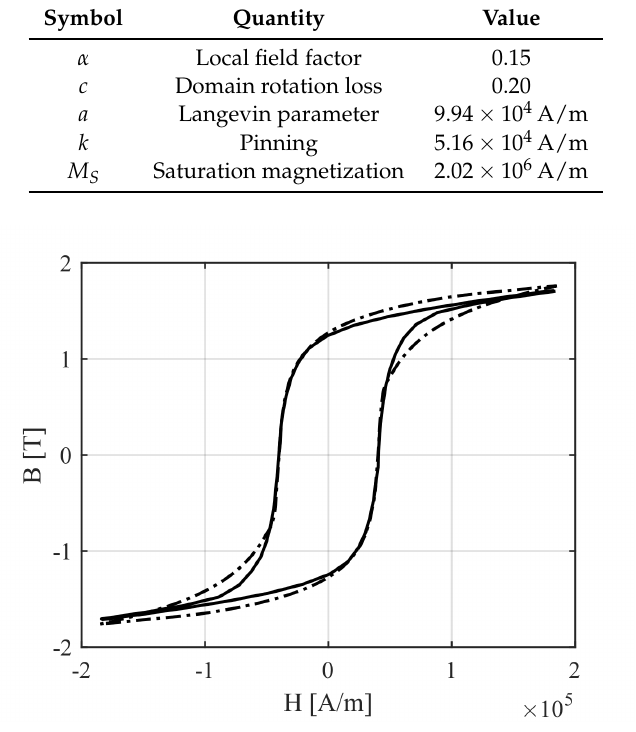
Figure 9. Magnetic characteristic of the FeCrCo 48/5 alloy: experimental (solid) and numerical (dash-dotted)